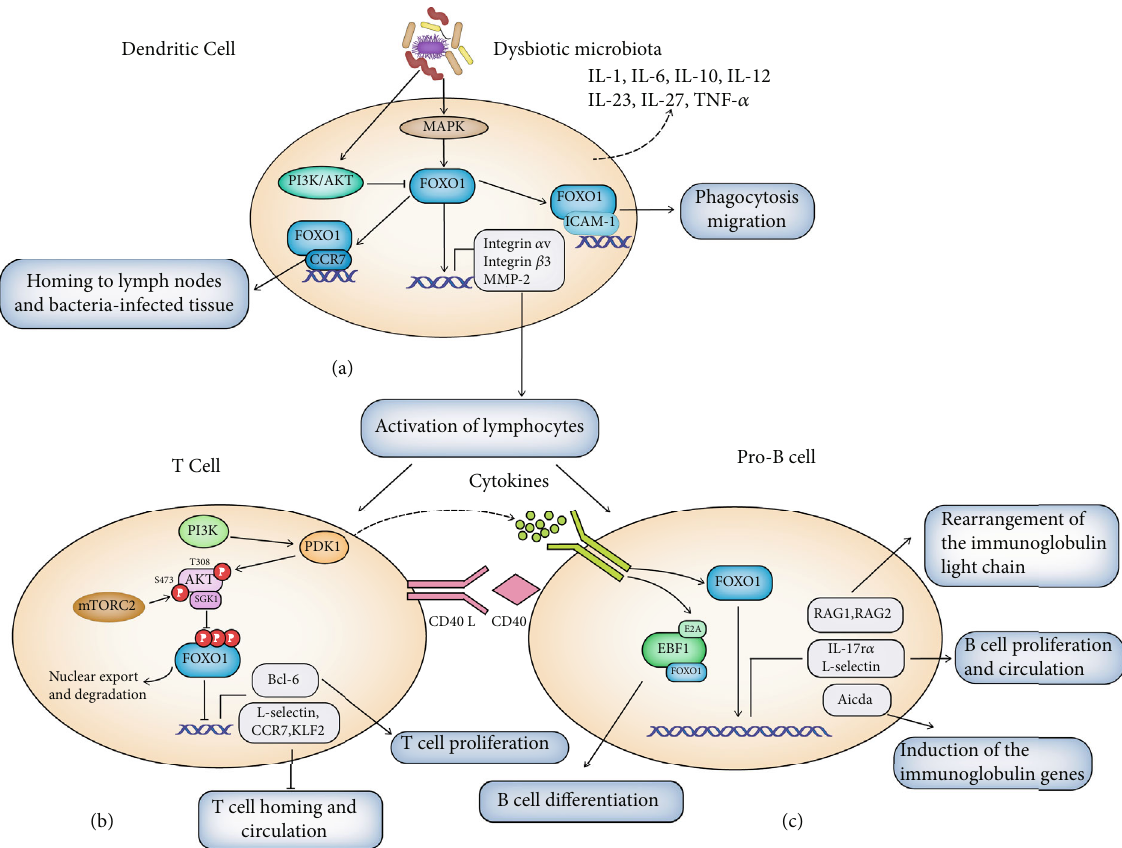
Figure 3: FOXO1 participates in function of DCs, T cells, and pro-B cells. (a) Dysbiotic microbiota stimulation initiates a signaling cascade to regulate the activity of FOXO1 via the MAPK and PI3K/AKT pathways. Activated FOXO1 can upregulate the transcription of CCR7, ICAM- 1, integrin α v, integrin β 3, and MMP-2, thus homing DCs to lymph nodes and bacteria-infected tissue, promoting phagocytosis migration and activation of lymphocytes. (b) FOXO1 associates with T cell proliferation, T cell homing, and circulation, which depend on counteracting the PI3K-, mTORC2-, and AKT-dependent negative regulation of FOXO1. (c) In pro-B cell, FOXO1 can be activated by various cytokines and participates in rearrangement of the immunoglobulin light chain, B cell proliferation and circulation, and B cell di ff erentiation by promoting expression of key target genes, such as RAG1, RAG2, IL-17r α , L-selectin, Aicda, and